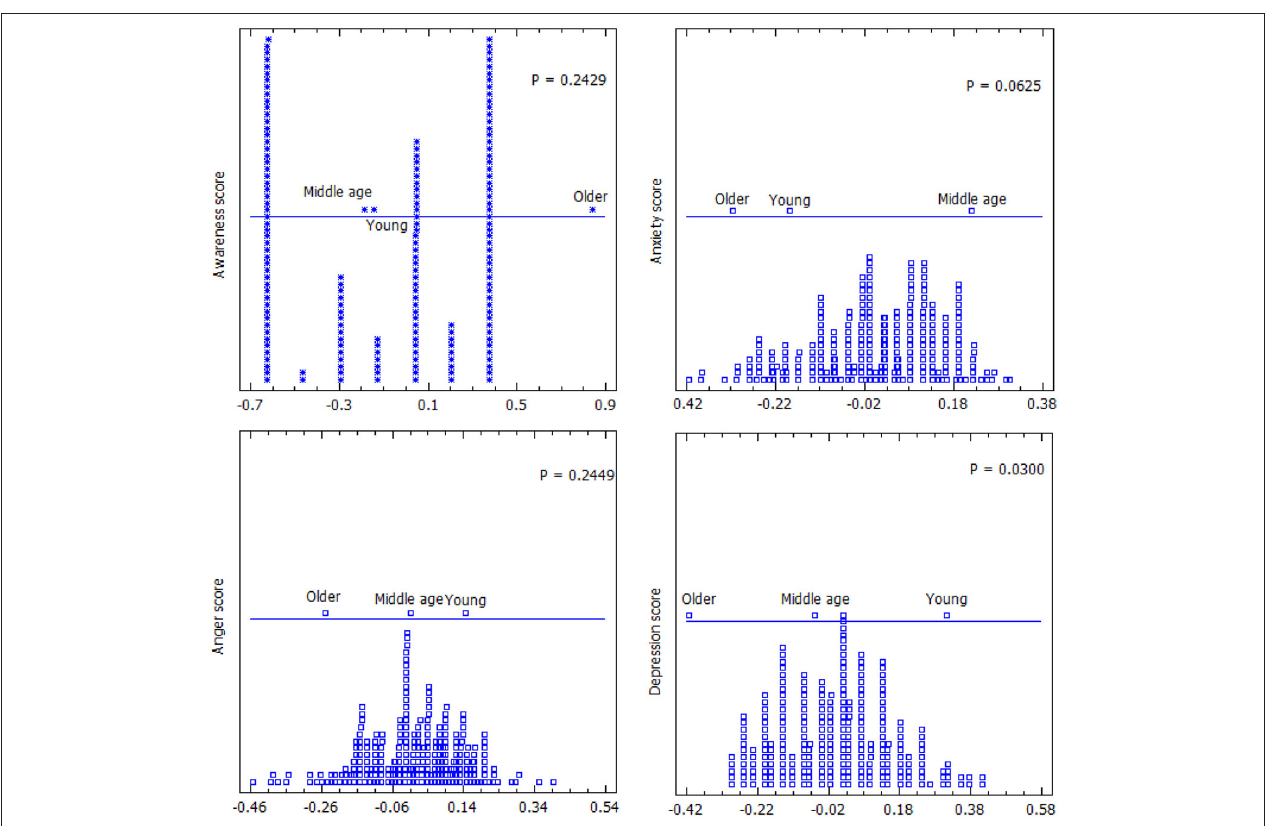
FIGURE 3 | Composite score difference for awareness, anxiety, anger, and depression between the different age groups.